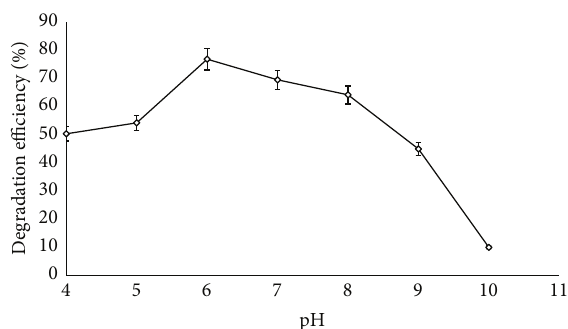
Figure 3: Effect of inoculum size on degradation of corn cob by S. carnis (error bars represent mean values and standard deviation of triplicate determination).